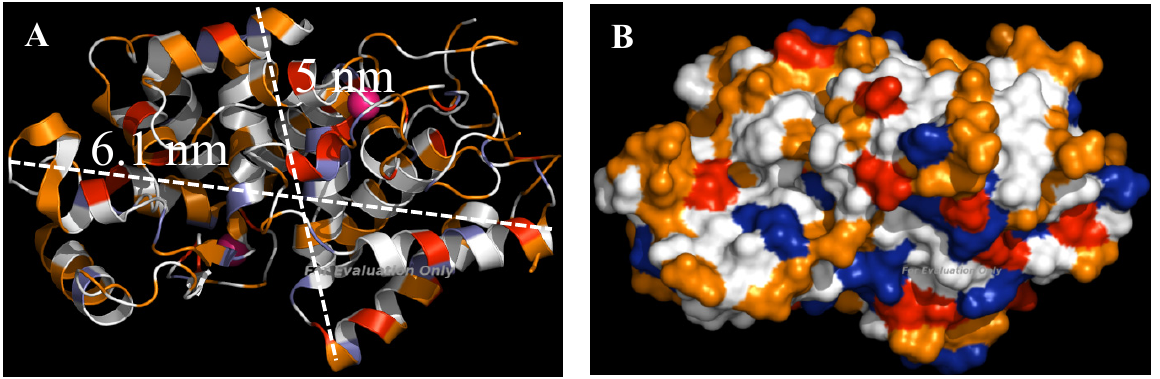
Figure 5. ( A ) Average dimensions of laccase measured in PyMOL (~6.1 nm × 5.0 nm × 4.9 nm). ( B ) Surface distribution of amino acids in laccase constructed in PyMOL (blue, basic amino acids; red, acidic amino acids; orange, polar amino acids; white, nonpolar amino acids; pink, copper